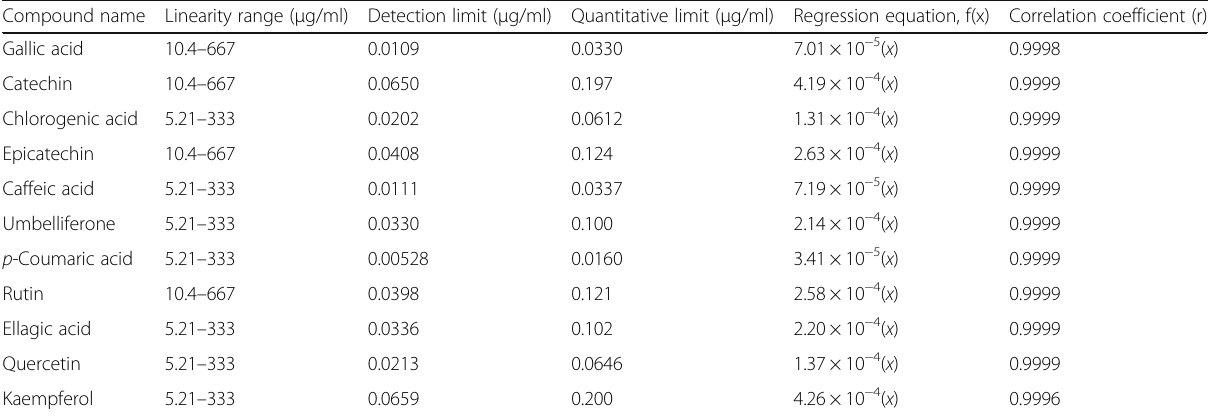
Table 4 HPLC-PDA method detection and quantification limit of eleven polyphenolic compounds with linearity